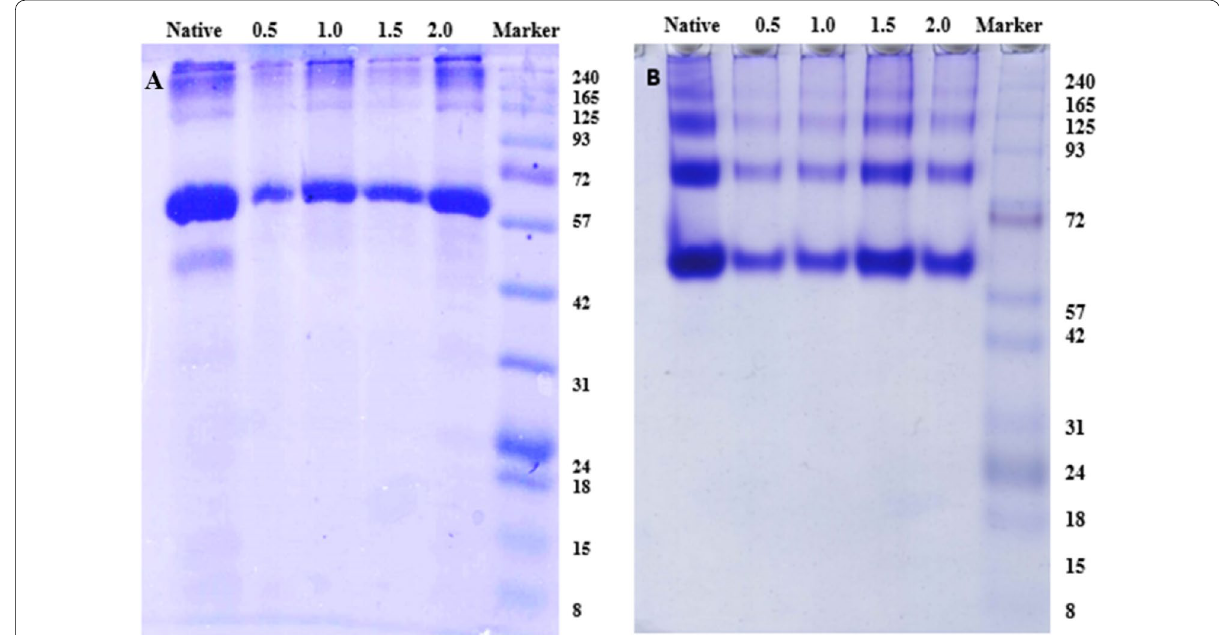
Fig. 3 Integrity assessment of BSA encapsulated into nanoparticles by running extracted protein on SDS PAGE ( a ) and native PAGE ( b )